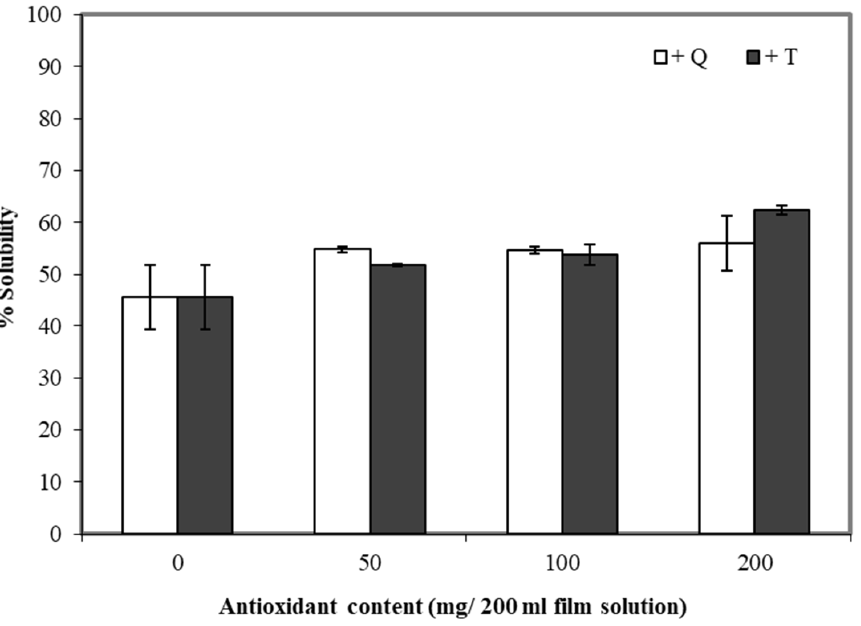
Figure 6. Effect of quercetin (Q) and TBHQ (T) incorporation on water solubility of cassava starch/gelatin films.